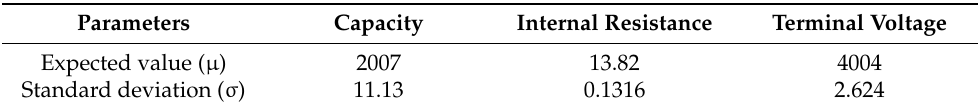
Table 3. Statistical distribution of cell